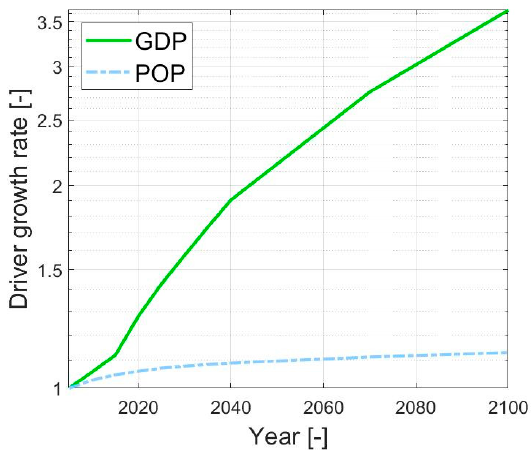
Figure 5. ETM Driver projections for EUR region [10].